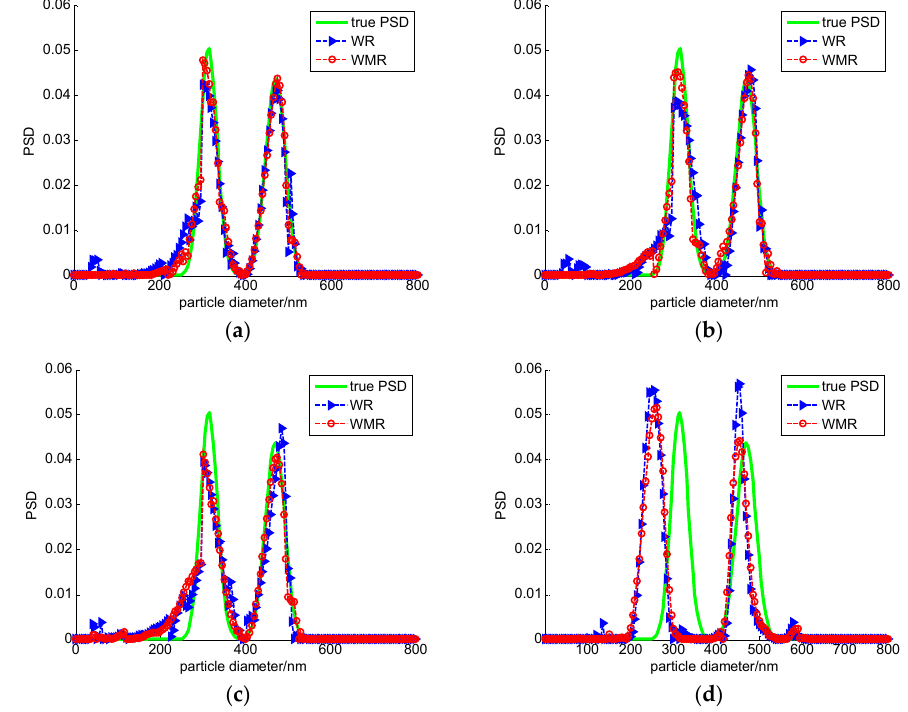
Figure 2. The inversion results with WR and WMR from 316/470 nm bimodal simulated DLS data under different noise levels: ( a ) noise level is 0; ( b ) noise level is 10 − 4 ; ( c ) noise level is 10 − 2 ; ( d ) noise level is 0.08.